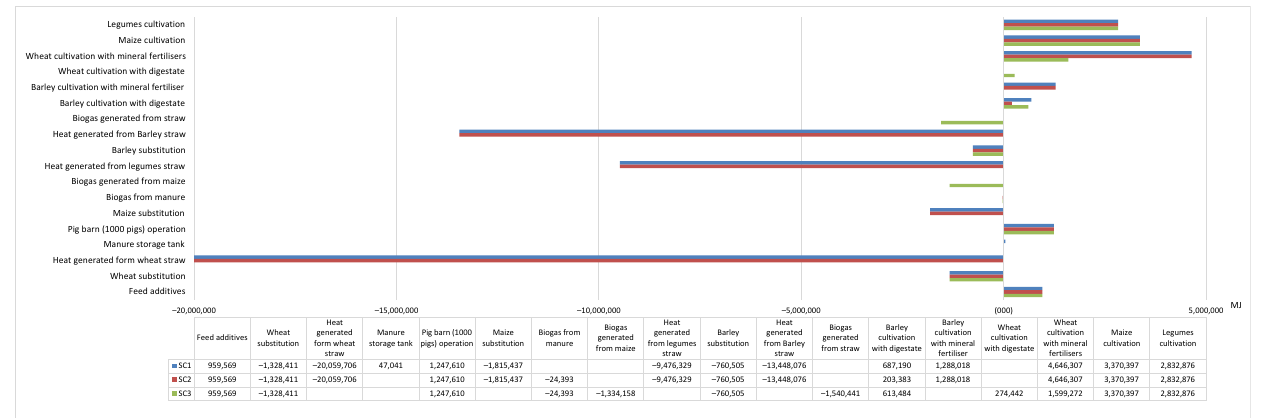
Figure 6. Results of processes for global warming potential.